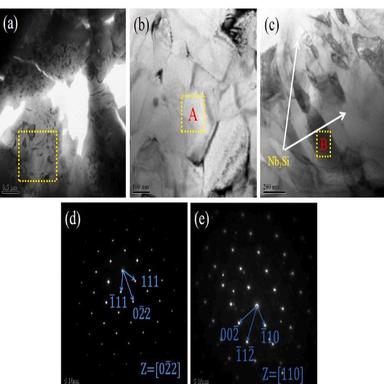
(a) Nb3Si cellular grains, (b) high magnification of cellular grains in (a), (c) Nb/Nb3Si cellular eutectic, (d) SAED pattern of region A in (b) (calibrated as Nb3Si phase), (e) SAED pattern of region B in (c) (calibrated as Nb phase).